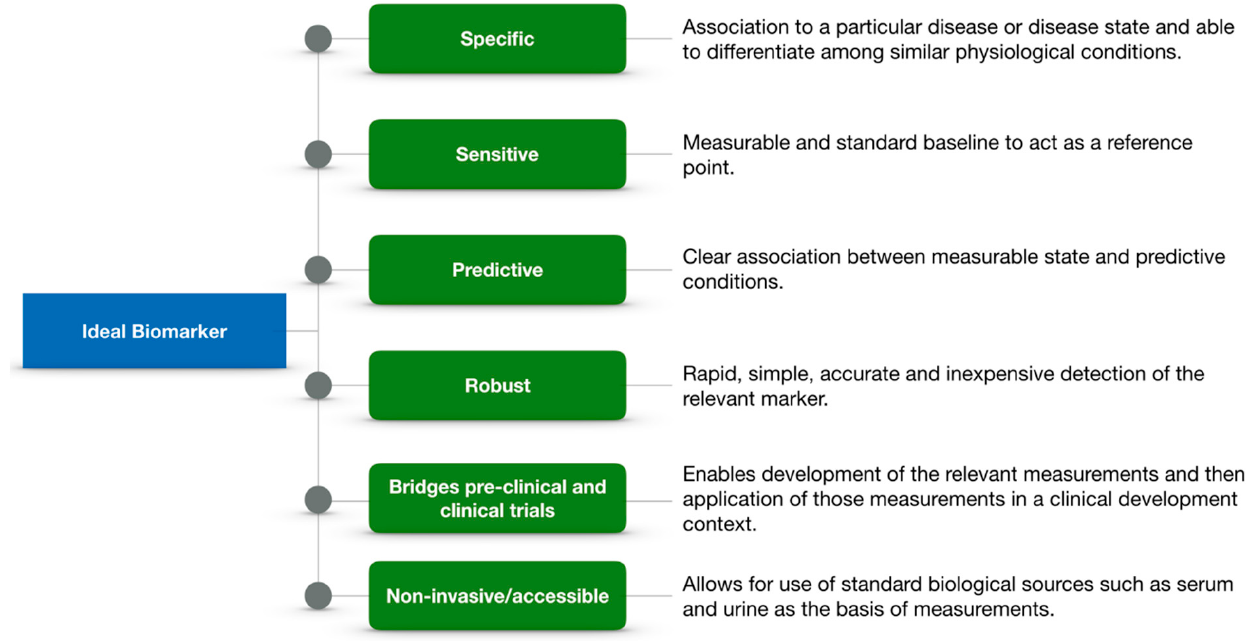
Figure 3. Definition of an Ideal Biomarker. According to the US-FDA, an ideal biomarker should be specific, sensitive, predictive, robust, able to bridge preclinical and clinical trials, and accessible.